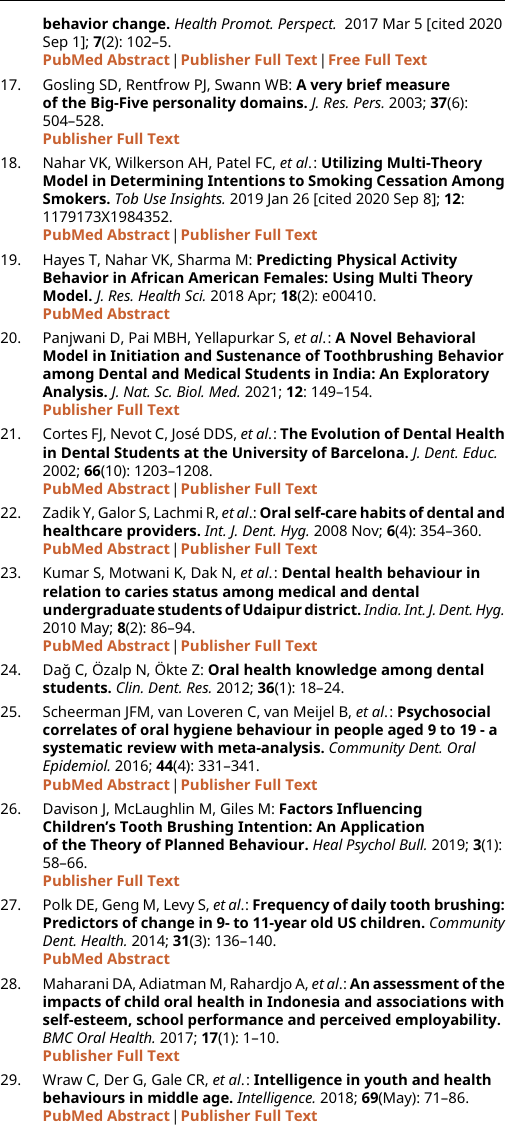
Figshare: Novel behavioral model in evaluating initiation and sustenance of teeth brushing behavior among students pursuing health sciences: a cross-sectional study. https://doi.org/10.6084/m9.figshare.19312103.v1 32 - MTM Questionnaire.docx (Example of questionnaire